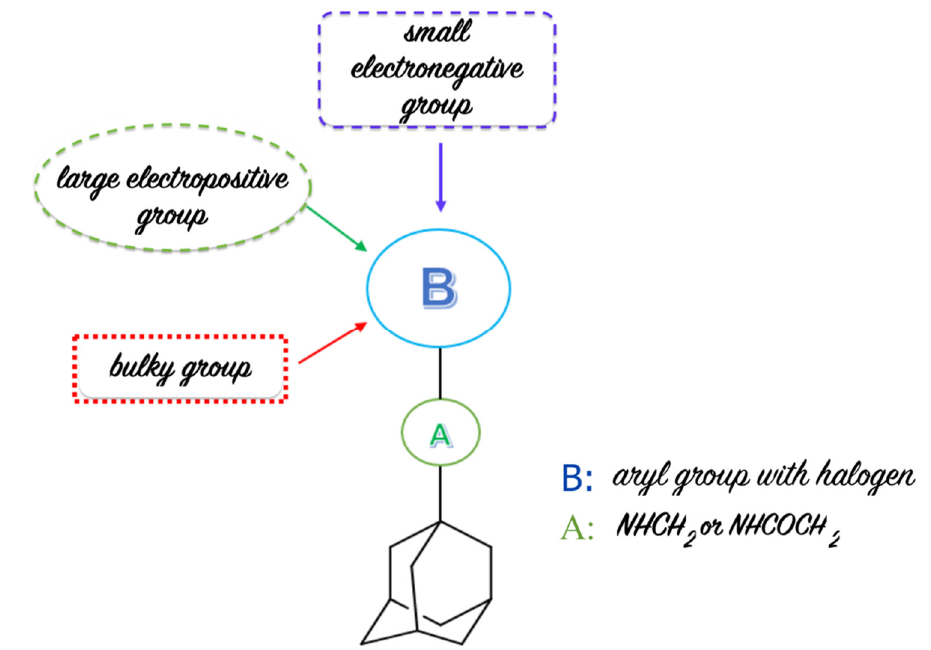
Scheme 3. Suggested scaffold based on the 3D-QSAR CoMFA model.